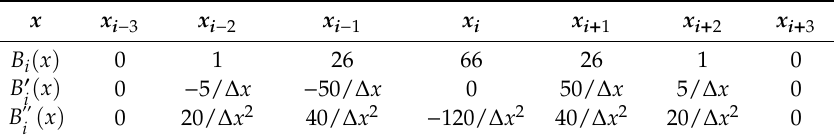
Table 1. The values of B i ( x ) and its derivatives at nodal points.